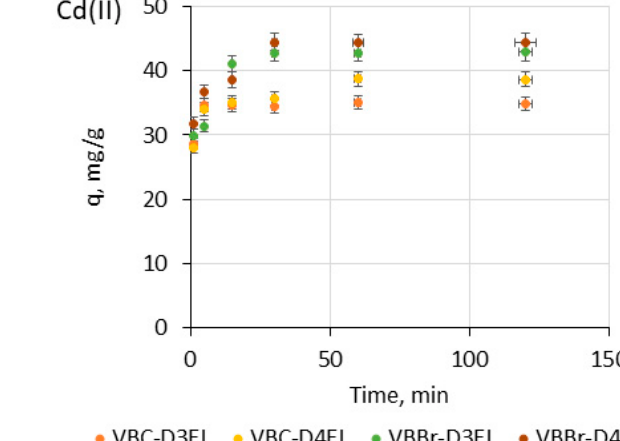
Figure 7. Experimental data of adsorption kinetic and non-linear fitting of kinetic models for adsorption of Pb(II) and Cd(II) onto resin surfaces (metal ion concentration, 50 mg/L; sorbent dosage, 0.1 g; V, 100 mL, pH 5).